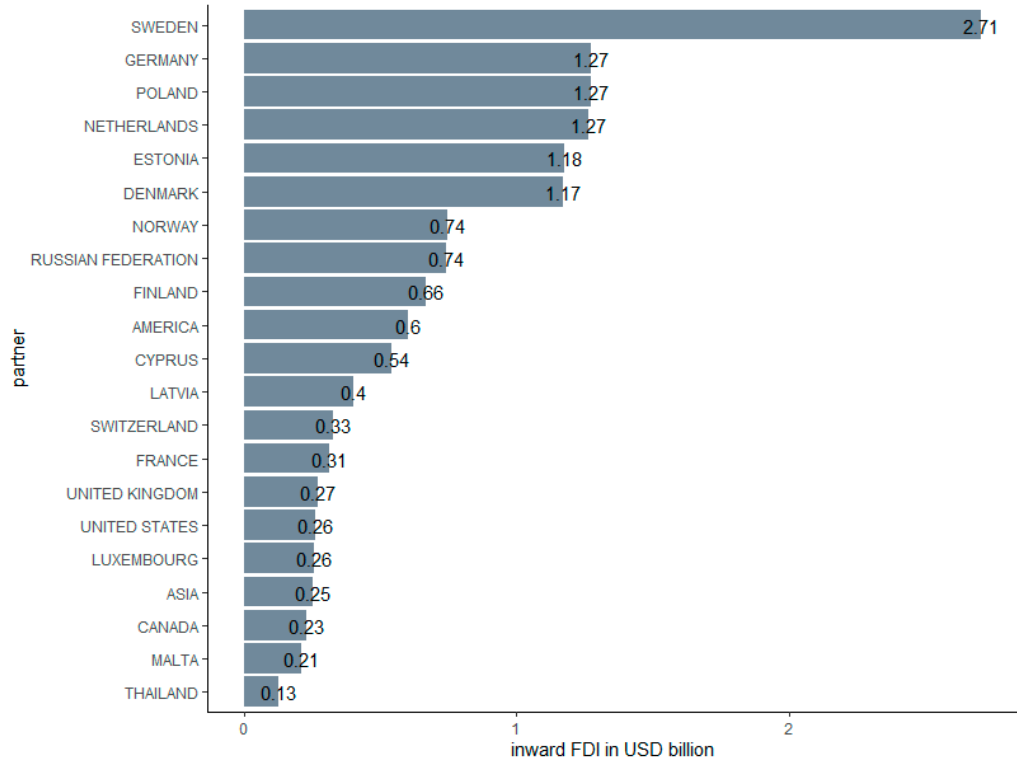
Figure A5. Average inward FDI stocks in economic sectors of Lithuania across 2004–2017.